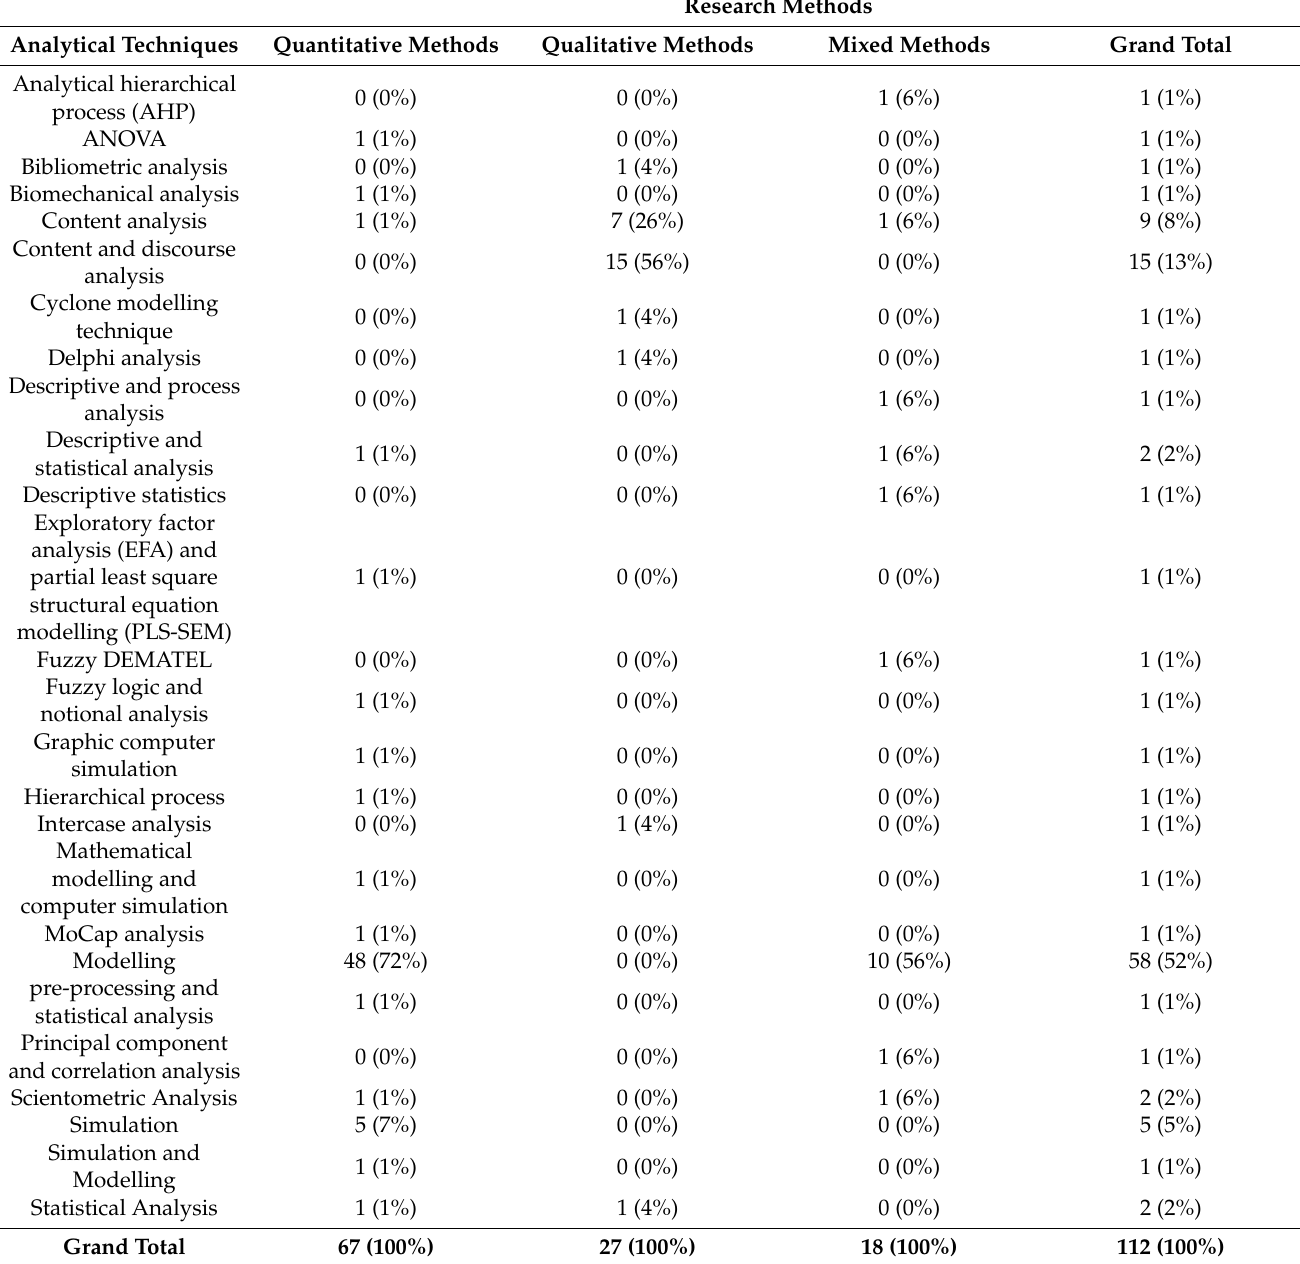
Table 3. Crosstabulation between Research Methods and Analytical Techniques used in the construc- tion robotics